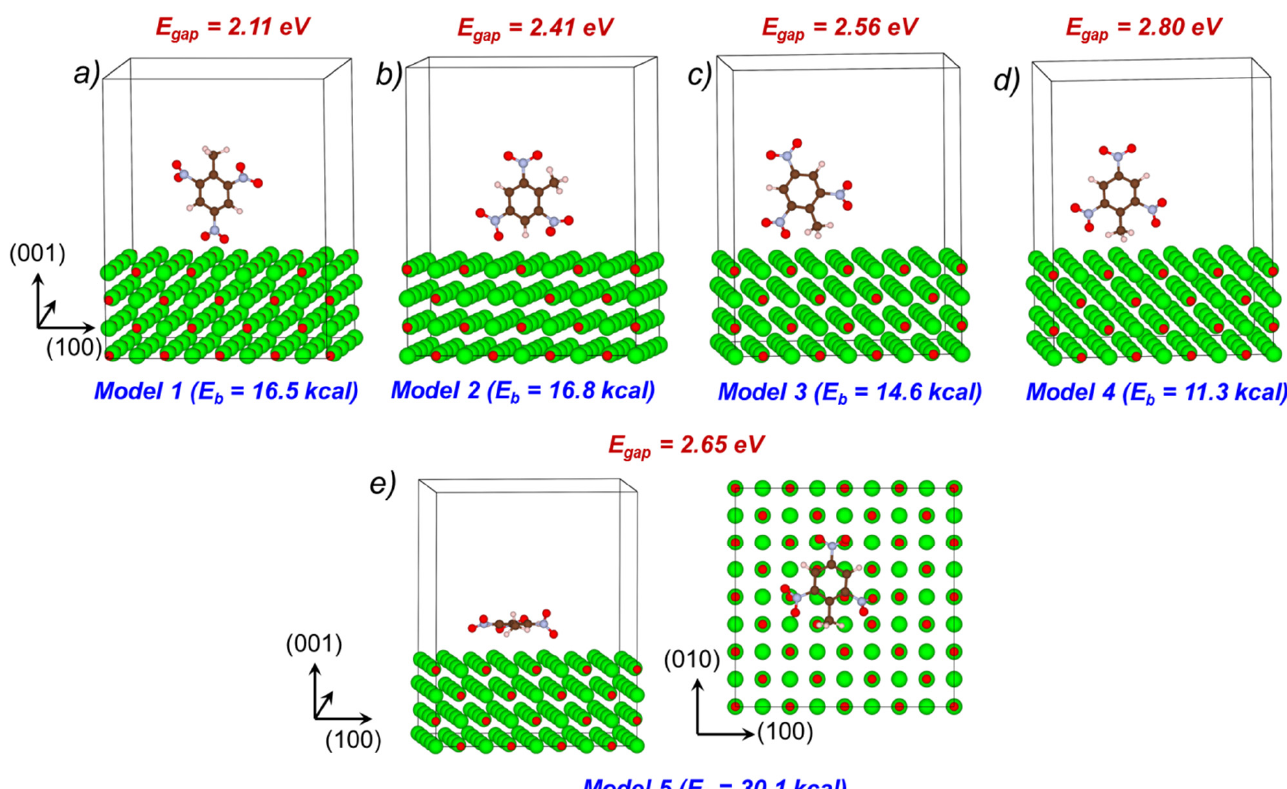
Figure 4. Several slab models with different orientation of a single TNT molecule adsorbed at a pristine (001) MgO surface. For each configuration, the binding energy ( E b ) and the bandgap ( E gap ) are shown. Mg—in green, O—in red, C—in brown, N—in blue, H—in white.